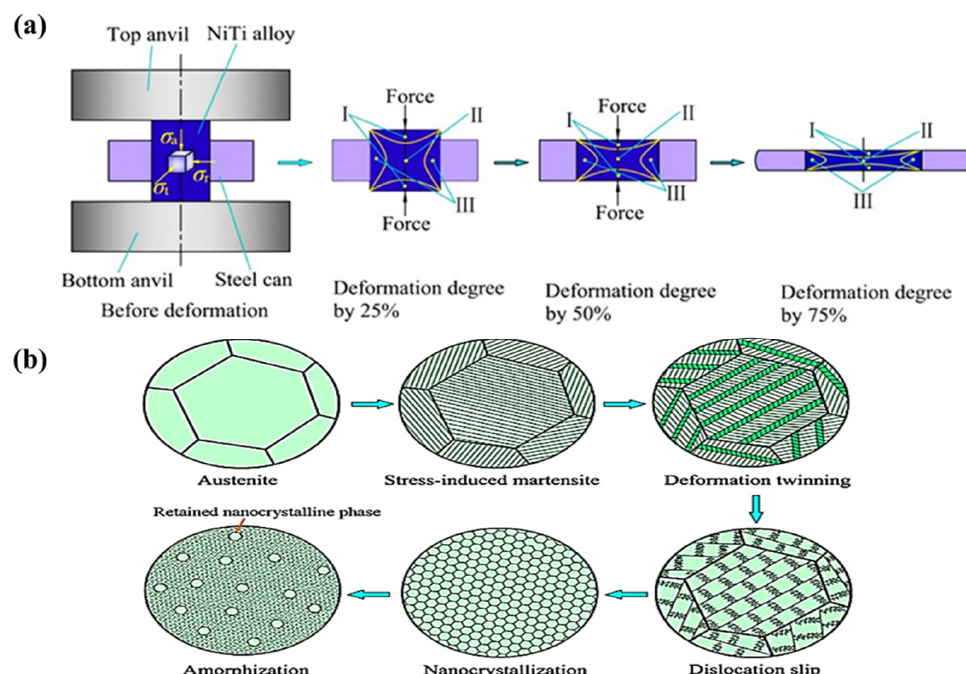
Figure 11. ( a ) Schematic representation for the local canning compression processing (region I shows the minimum deformation zone, region II illustrates the main deformation zone, and region III depicts the intermediate deformation zone) [56], and ( b ) nanocrystallization and amorphization mechanism for the TiNi sample under local canning compression, adapted with permission from [56], 2022, Elsevier.